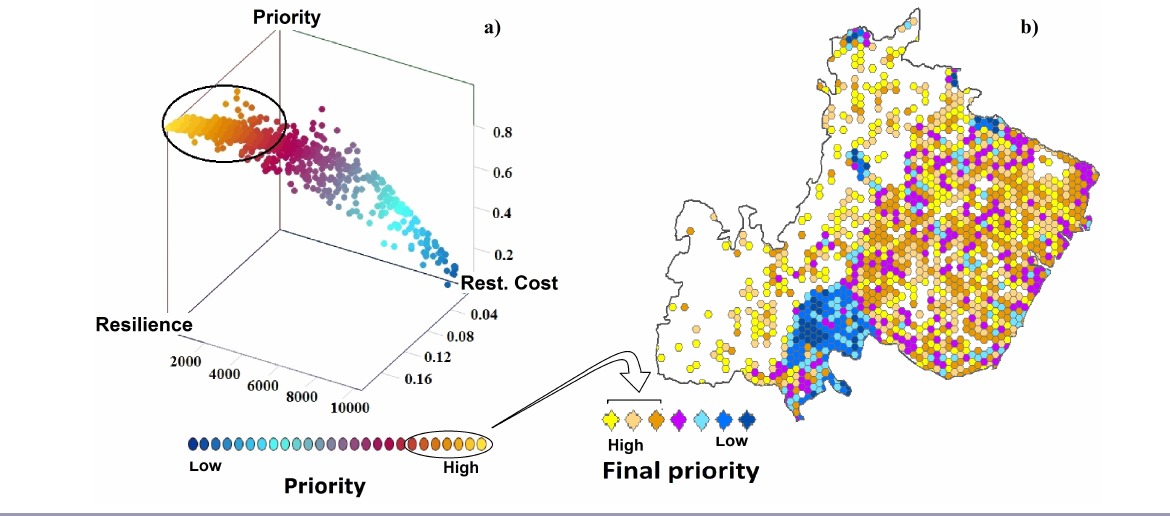
Fig. 6 . (a) Three-dimensional plot relating the landscape resilience, restoration cost, and respective priorities index on the z-axis of 1423 planning units (PUs) with deficit to the habitat target of 30%. The black outlines highlight the PUs whose values are less than 2271 restoration cost (average) but with resilience range greater than 0.08. (b) Map of priorities highlighting (yellow to orange colors) the 875 PUs from selection by restoration cost scenario, which were weighted by restoration cost and resilience. PUs into range of blue we predict the greatest conflicts to legal reserve